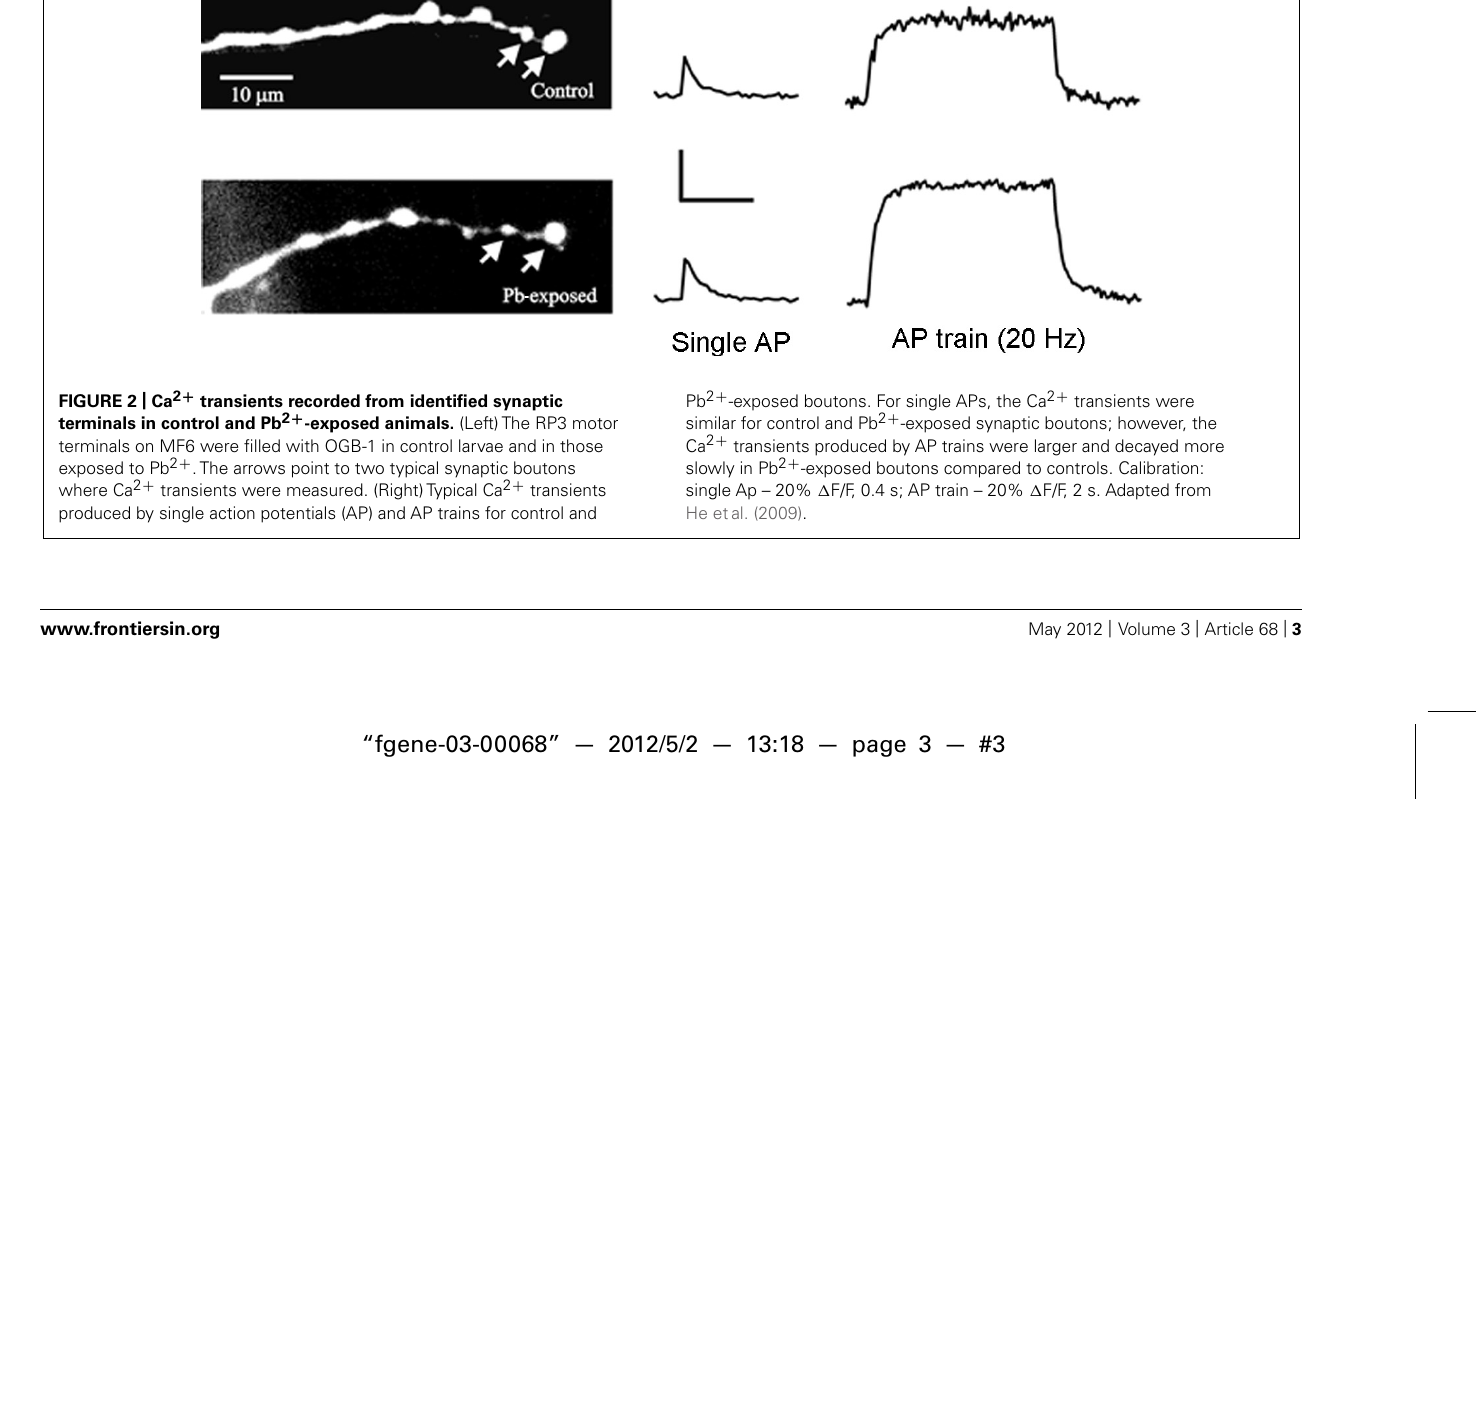
FIGURE 2 | Ca 2 + transients recorded from identified synaptic terminals in control and Pb 2 + -exposed animals. (Left)The RP3 motor terminals on MF6 were filled with OGB-1 in control larvae and in those exposed to Pb 2 + .The arrows point to two typical synaptic boutons where Ca 2 + transients were measured. (Right)Typical Ca 2 + transients produced by single action potentials (AP) and AP trains for control and